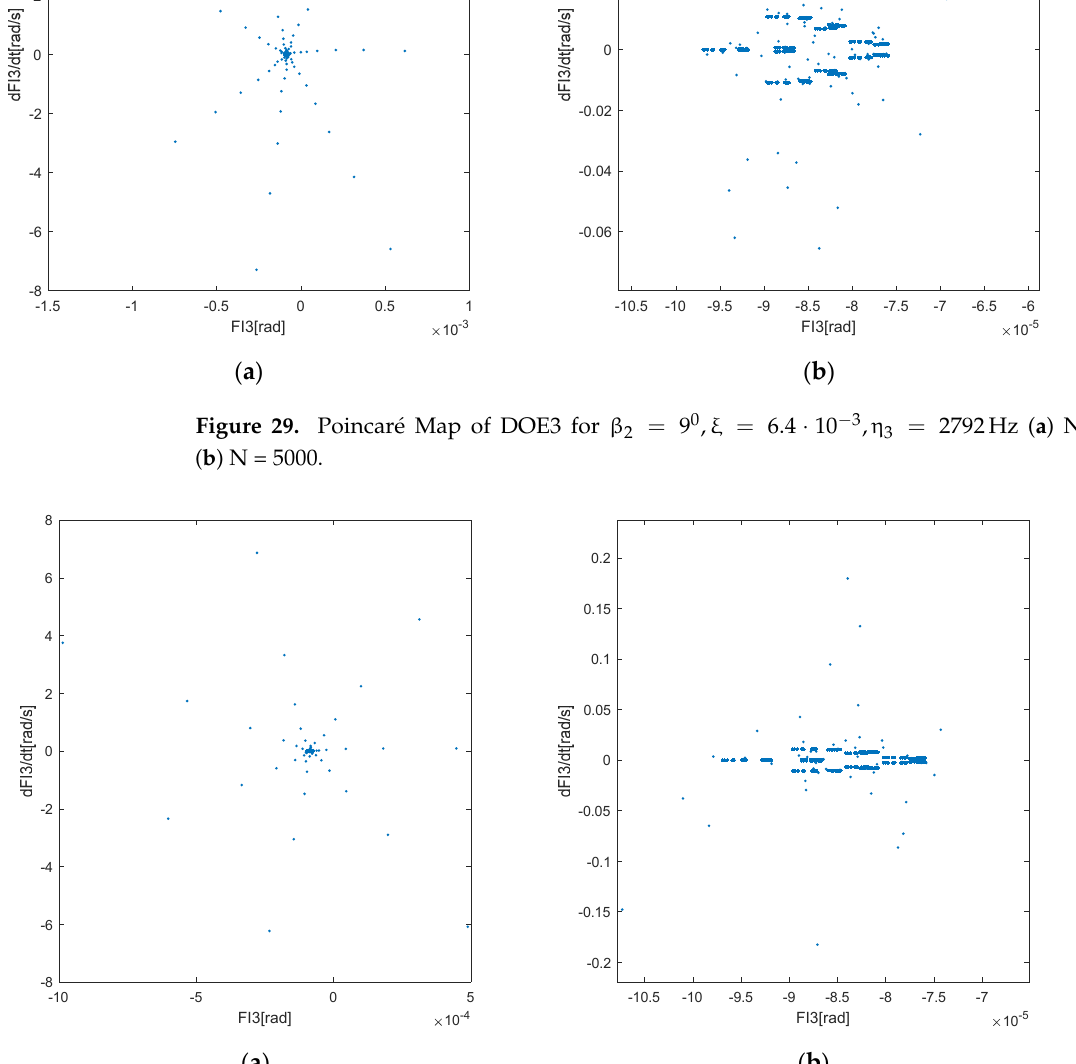
Figure 30. Poincaré Map of DOE3 for Figure 30. Poincar é Map of DOE3 for β 2 = 9 0 , ξ = 10.4 · 10 − 3 , η 3 = 2792Hz ( a ) N = 50,000 ( b ) N =